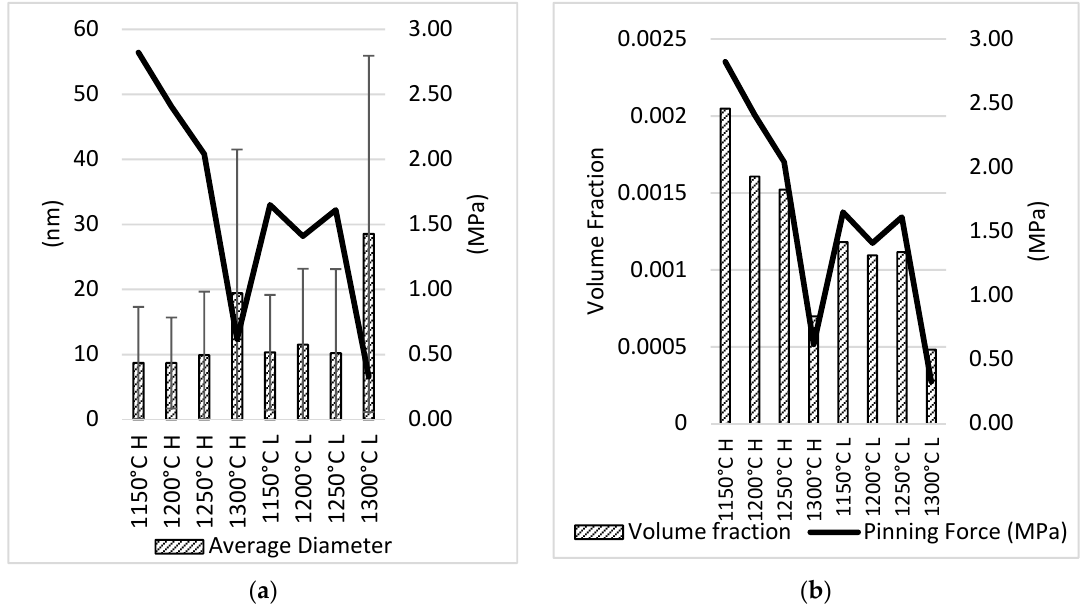
Figure 4. ( a ) Average diameter of precipitates at the different austenitization temperatures with soaking time of 1 h and corresponding pinning force; ( b ) volume fraction and corresponding pinning force. Measurements based on TEM micrography.